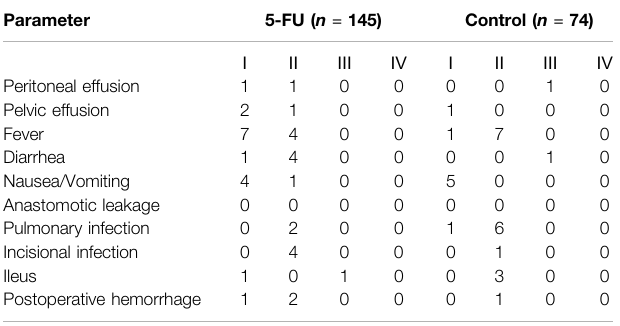
Table S1 ). 5-FU, 5- fl